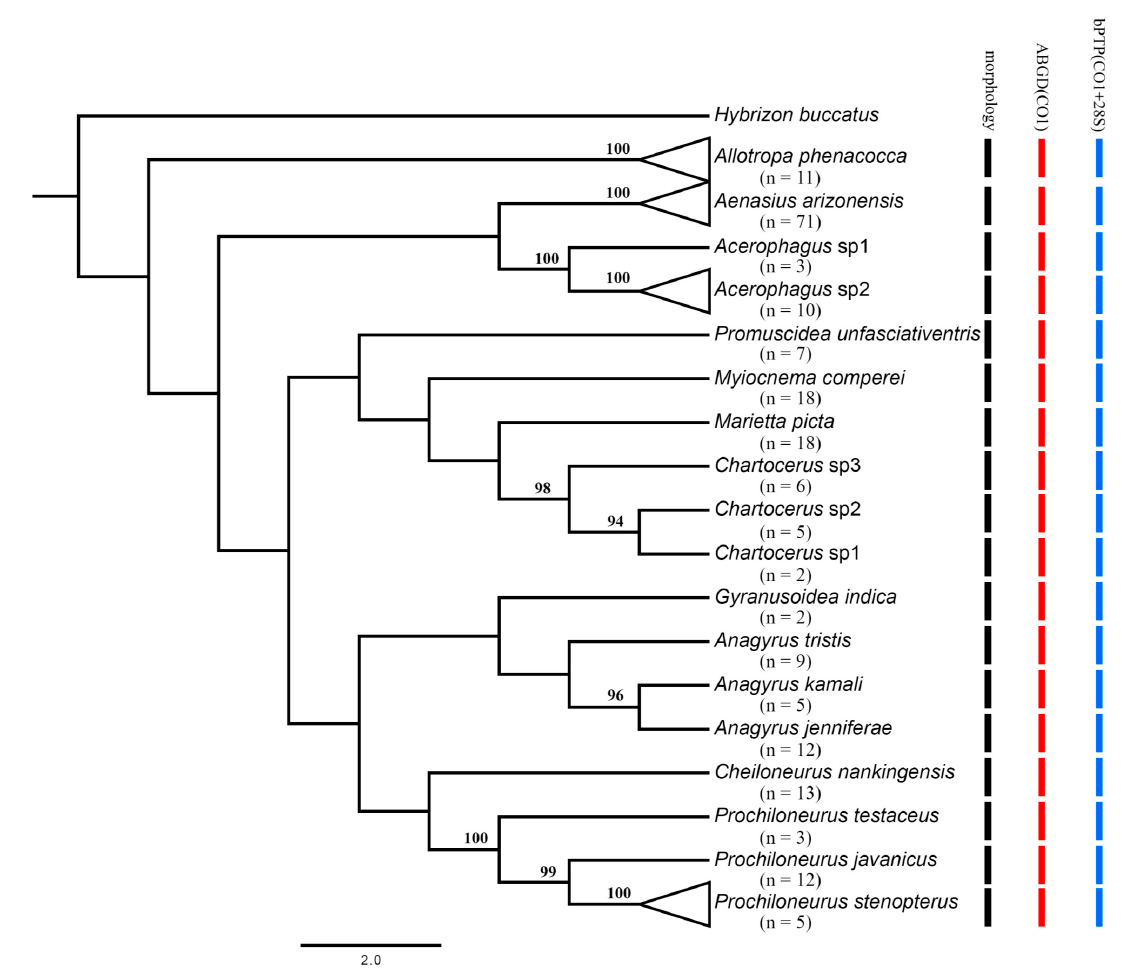
Figure 2. Maximum likelihood tree and results of species delimitation, only values >90 for bootstrap are labeled. The 18 species of parasitoids we identified and described below.